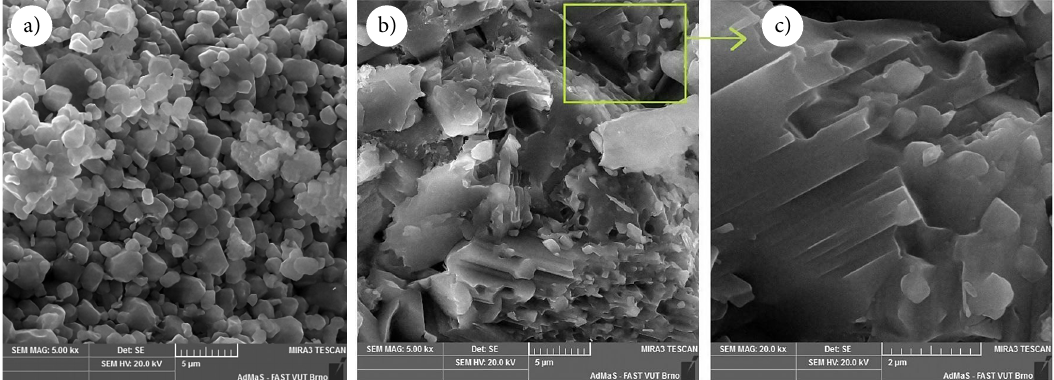
Figure 1. The microstructure of high strength fluoroanhydrite matrix: (а) – without plasticizer (5000-fold magnification), (b) – with the DC-5 plasticizer (5000-fold magnification), (c) – 20,000-fold microstructure fragment